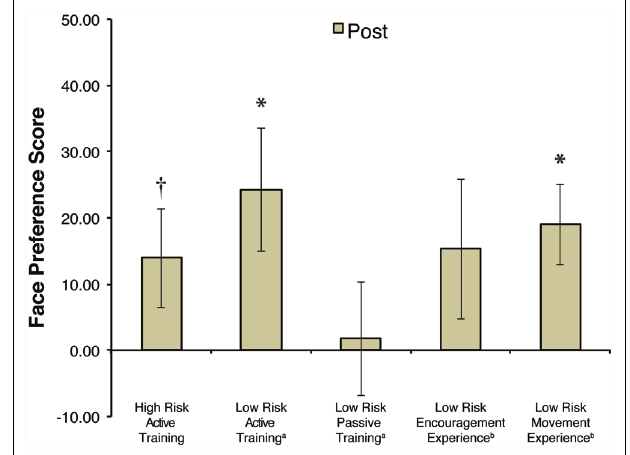
FIGURE 3 |Average grasping duration before (Pre) and after (Post) training by group. Data from the low risk (LR) groups was taken from (a) Libertus and Needham (2010) or (b) Libertus and Needham (2014). Error bars represent SEM, * p < 0.05.